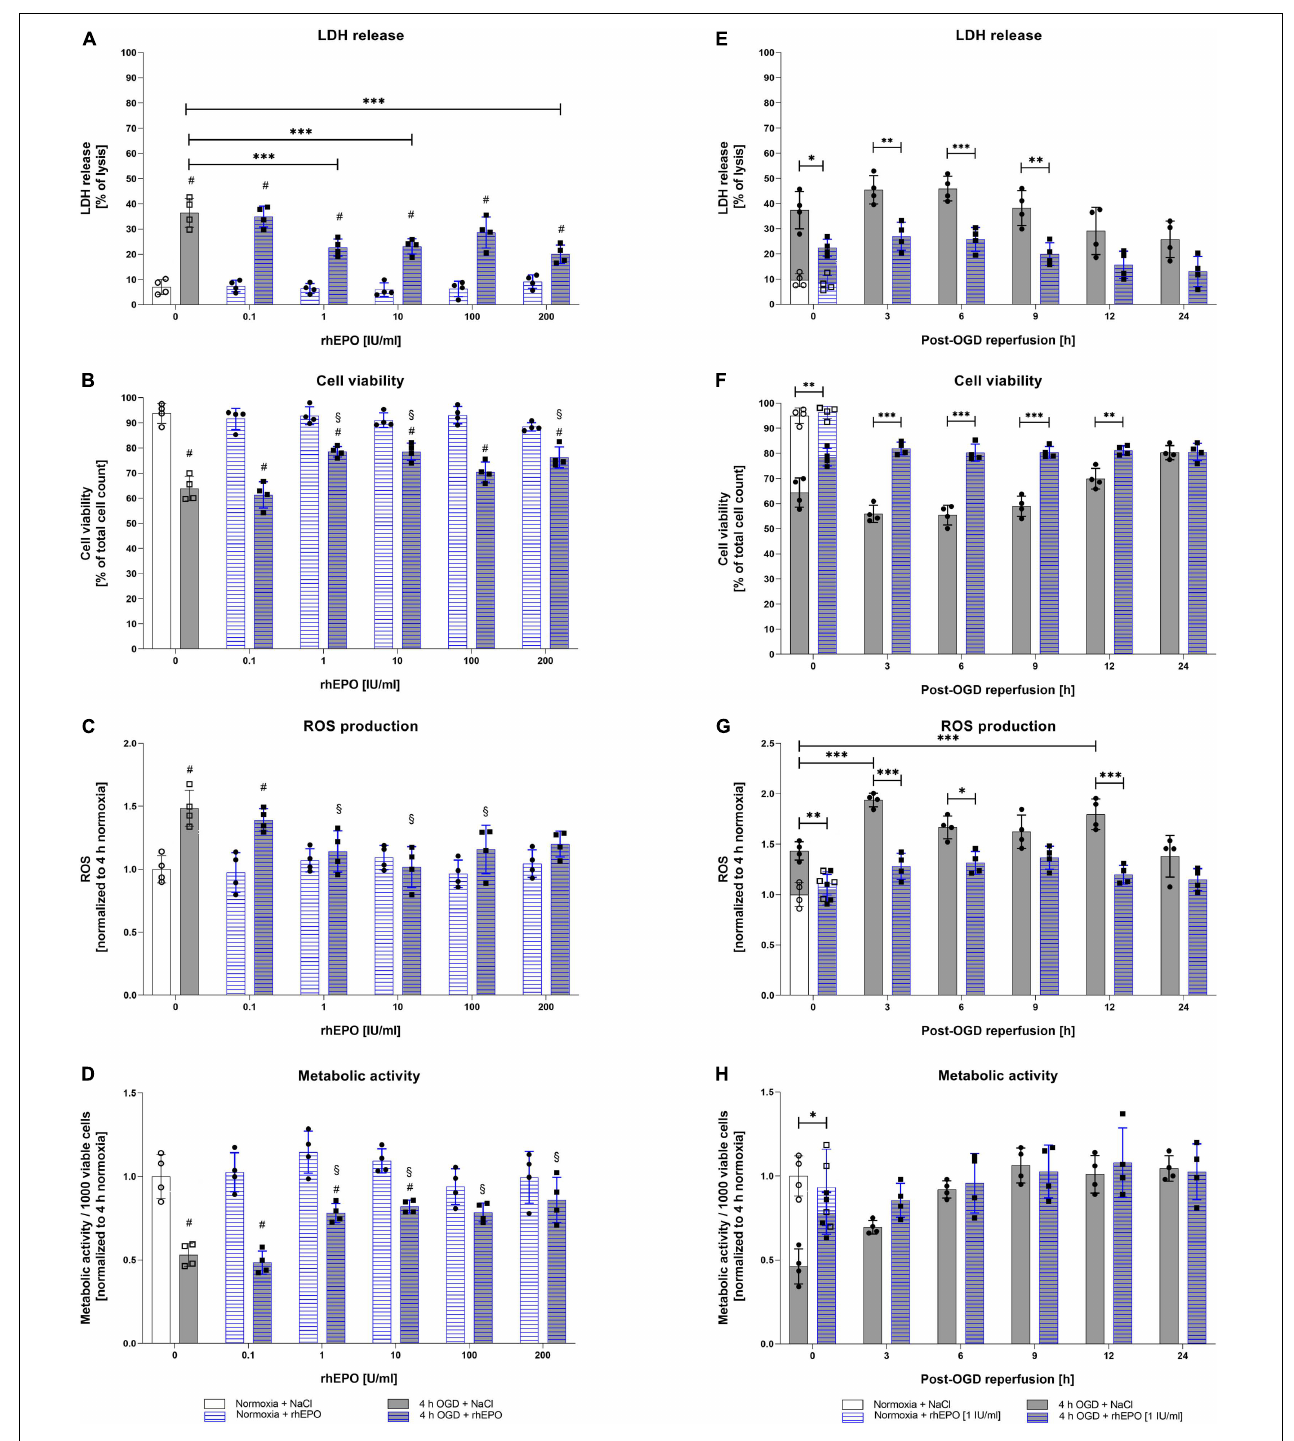
FIGURE 3 | Human recombinant erythropoietin (rhEPO) mitigates OGD-induced cell death, ROS production, and enhances metabolic activity in HMC-3 microglial cells. Dose-dependent impact of rhEPO [0.1–200 IU/ml] on (A) LDH release, (B) cell count, (C) ROS production, and (D) metabolic activity of HMC-3 microglial cells after 4 h of OGD or the corresponding normoxia control. Impact of a single-dose rhEPO [1 IU/ml] on (E) LDH release, (F) cell count, (G) ROS production and (H) metabolic activity after 4 h of OGD or normoxia followed by 24 h of reperfusion. Saline served as vehicle control (0.9% NaCl). Intergroup differences were tested by ANOVA two-way or three-way followed by Tukey post-hoc test (multiple groups). Bars represent means ± SD of 4 individual experiments with 3 technical replicates in each experiment, individual data points are shown. ∗ p < 0.05, ∗∗ p < 0.01, ∗∗∗ p < 0.001 between groups, § p < 0.05 compared to saline control. # p < 0.05 compared to normoxia